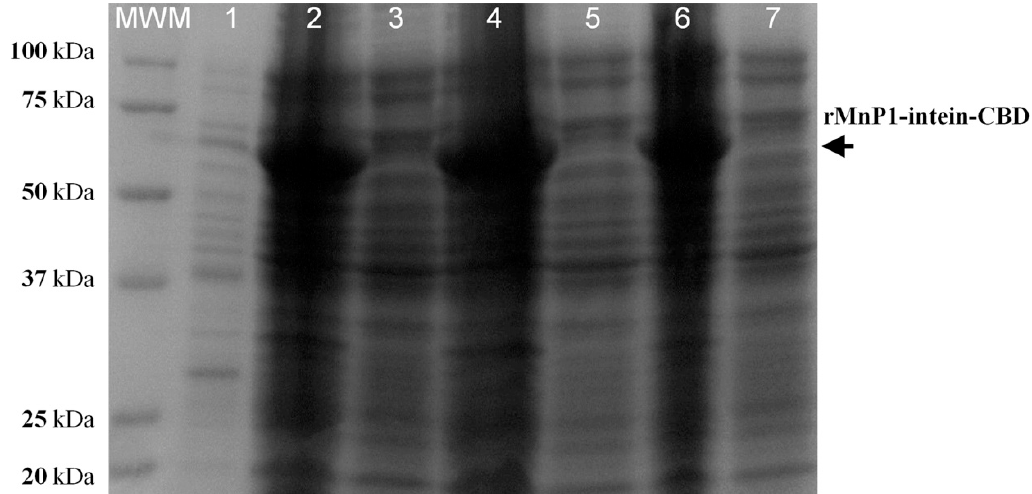
Figure 3. SDS-PAGE with uninduced and isopropyl- β -D thiogalactopyranoside (IPTG)-induced cells of E. coli T7 shu ffl e expressing the protein fusion rMnP1 − Intein − CBD. When cultures reached an OD 600nm of 0.5, they were induced with different concentrations of IPTG and incubated at 37 °C for 12 h: induction with 0.1 mM IPTG, insoluble (lane 2 ) and soluble (lane 3 ) fractions; induction with 0.4 m M IPTG, insoluble (lane 4 ) and soluble (lane 5 ) fractions; induction with 0.8 mM IPTG, insoluble (lane 6 ) and soluble (lane 7 ) fractions. Lane 1 : Uninduced with IPTG. MWM: Kaleidoscope Protein Standard.